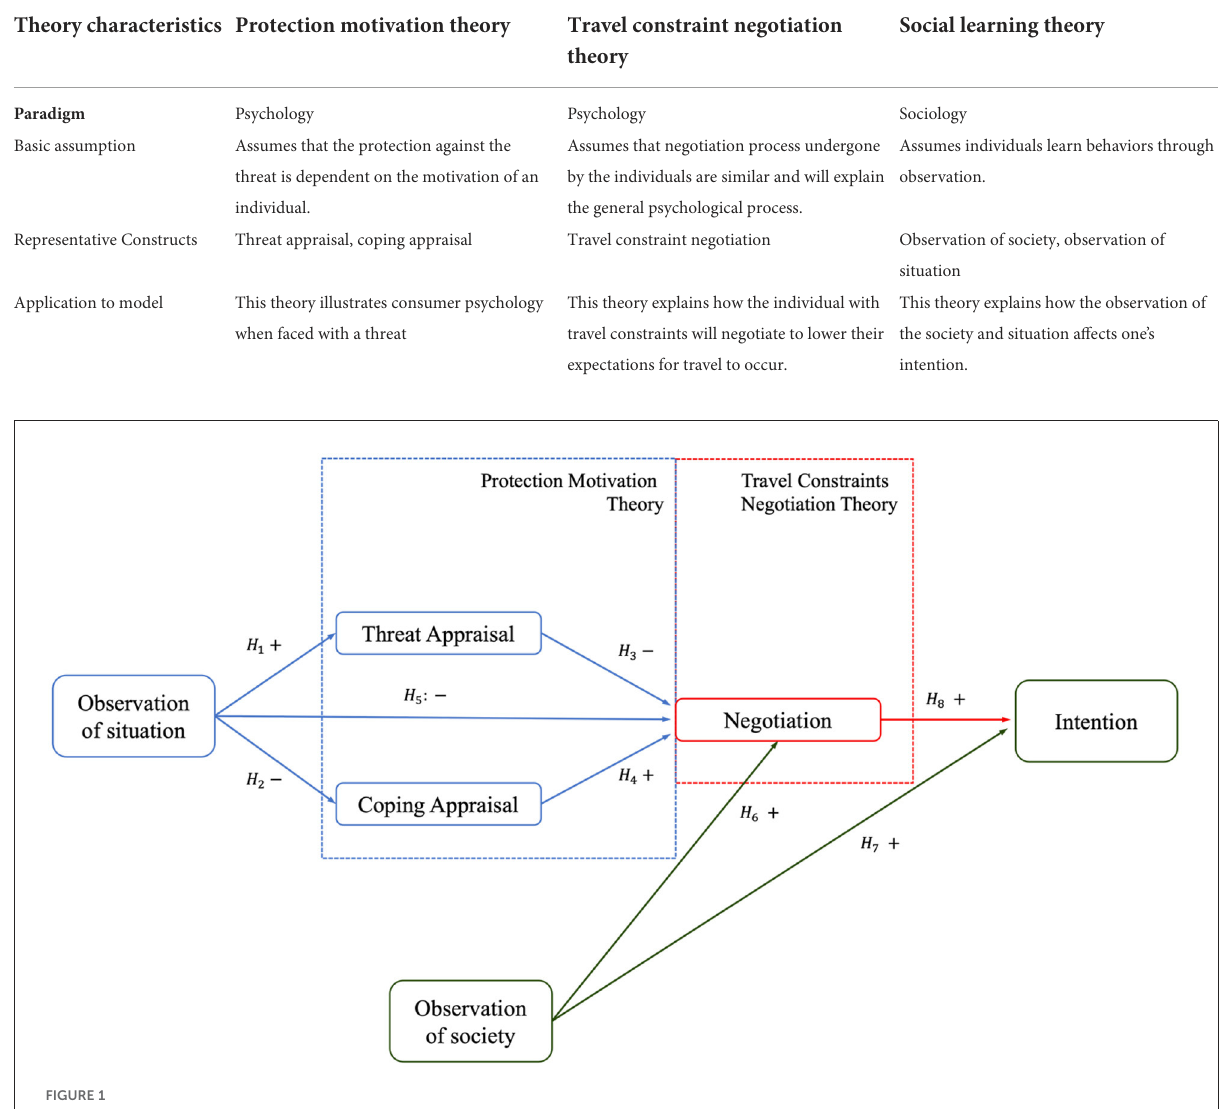
FIGURE1 Proposed theoretical